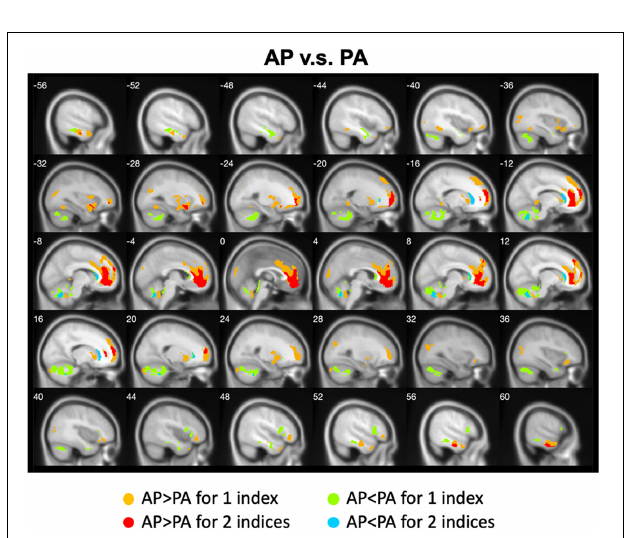
FIGURE 3 | Overlapped regions that showed different global brain connectivity (i.e., DC and rsFC of PCC) depending on PE direction (AP vs. PA). Light red indicates common regions for the two indices where the AP direction exhibited significantly higher FC than the PA direction. Light blue indicates the